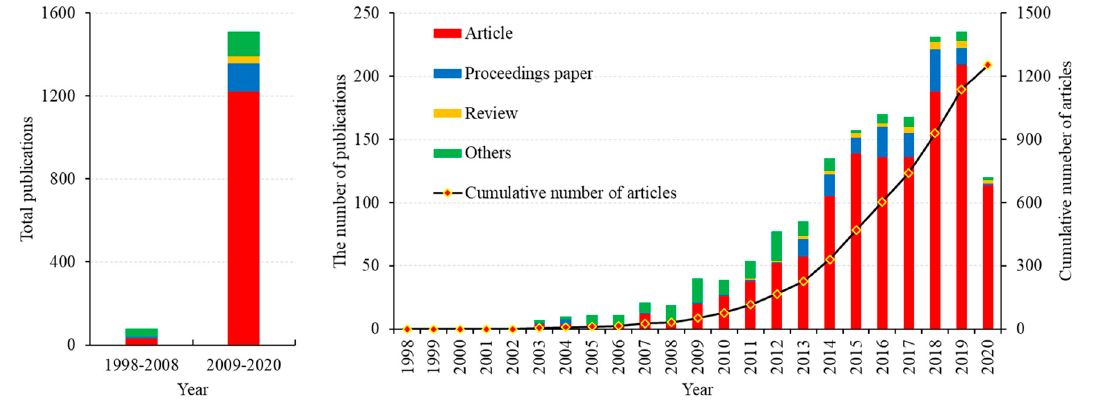
Figure 1. The number of publications.